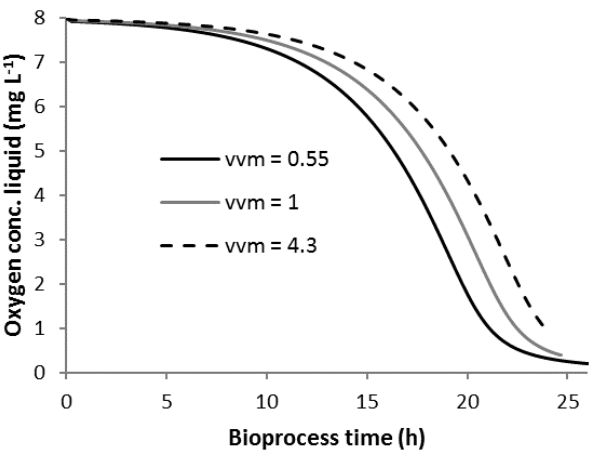
Figure 4. Scenario K: Evolution of oxygen concentration in bioprocess liquid when operating at Pag = 45 kW at vvm = 0.55, 1 and 4.3.